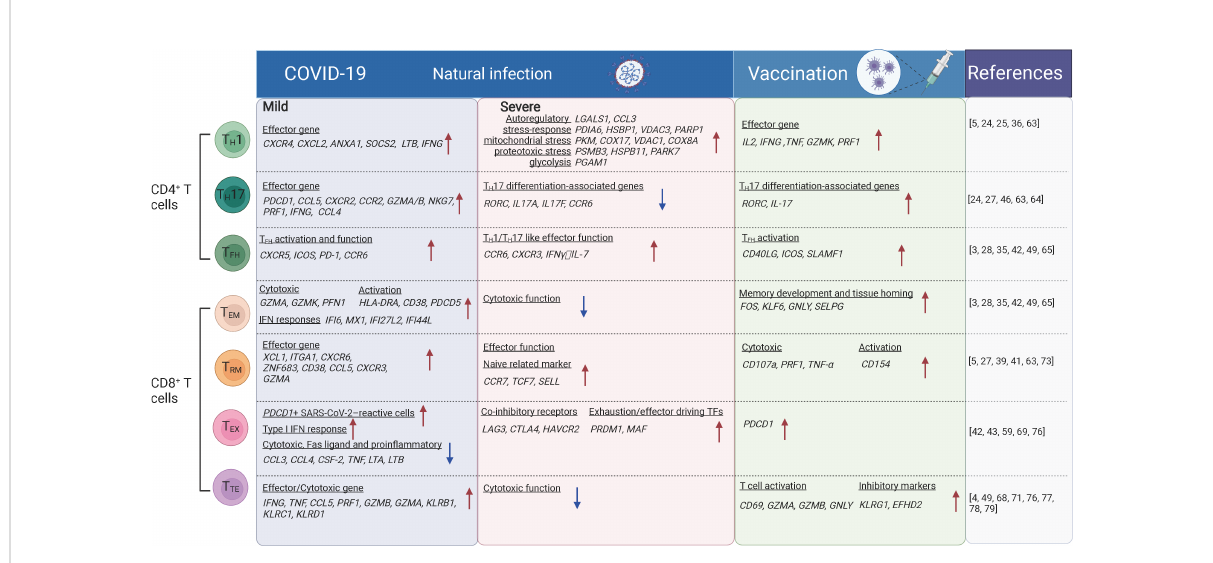
FIGURE 1 The T cell subsets and their transcriptional changes after SARS-CoV-2 vaccination and infection. The red arrows indicate the genes or pathways that were up-regulated in individuals with COVID-19 or vaccinated compared to the healthy donors, while blue arrows indicate the genes or pathways that were down-regulated. T H 1, T-helper 1 like cells; T FH , T follicular helper cells; T H 17, T-helper 17 like cells; T EM , effector memory; T TE , cytotoxic terminal effector; T EX , exhausted-like; T RM , tissue-resident memory cells. The fi gure was created using